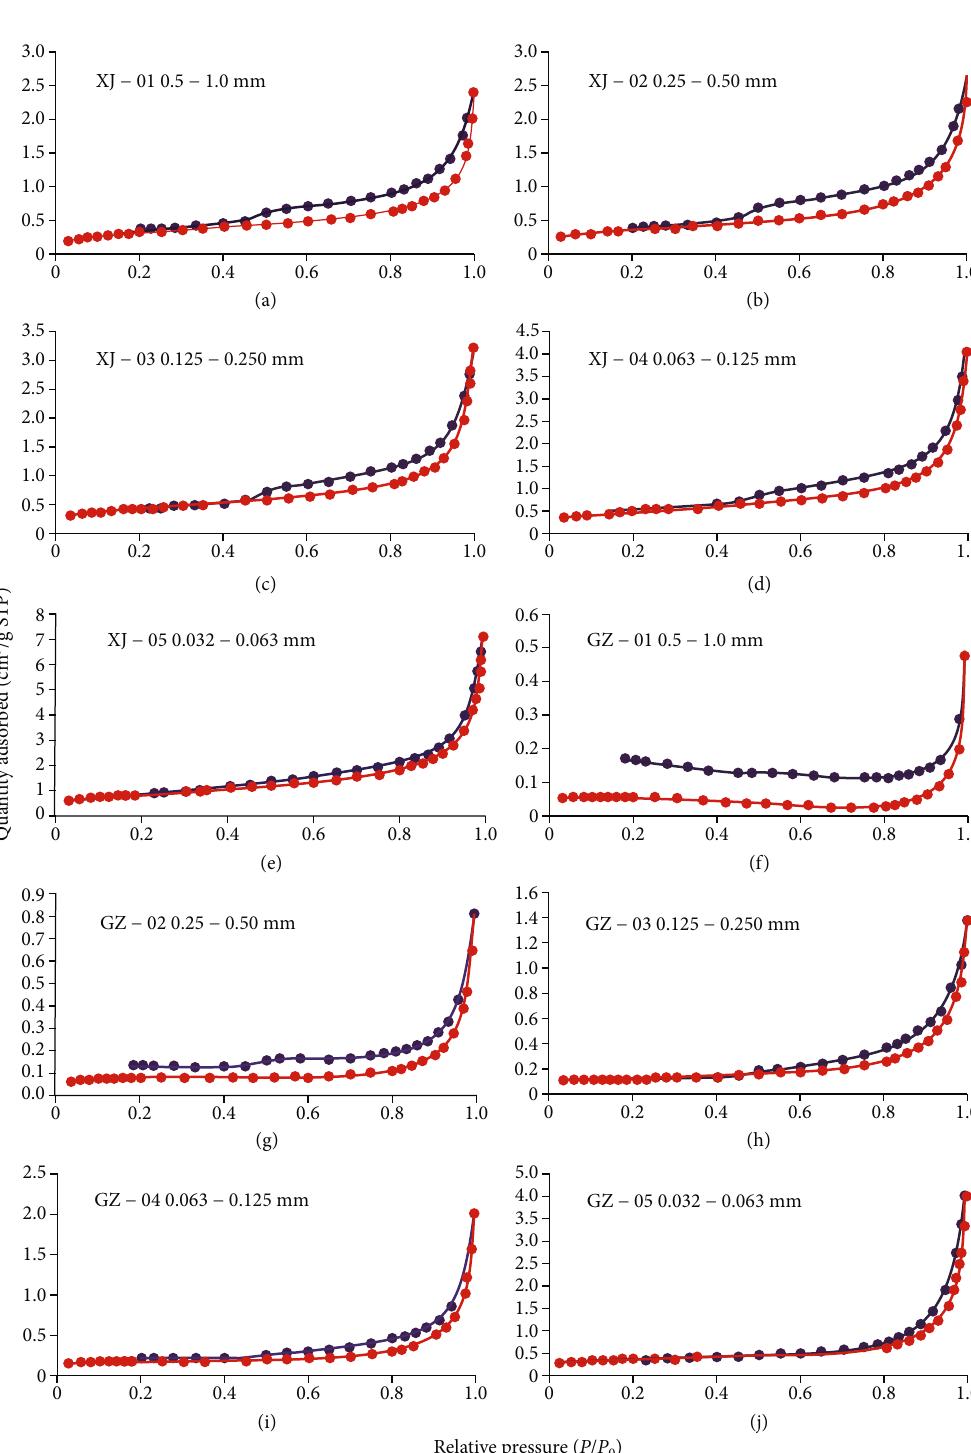
Figure 3: Low-pressure N adsorption-desorption isotherms of the subsamples with di ff erent particle sizes: (a – e) Coal XJ; (f – j) Coal 2